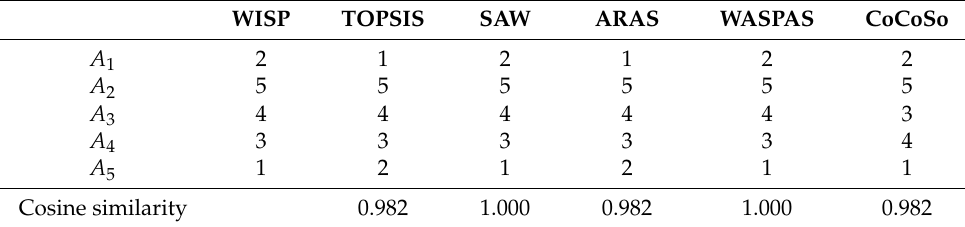
Table 3. The ranking orders obtained based on the first decision-making matrix.